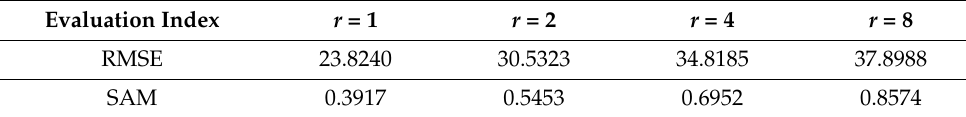
Table 2. Objective evaluation of DCGIF filtering results with different window radius.